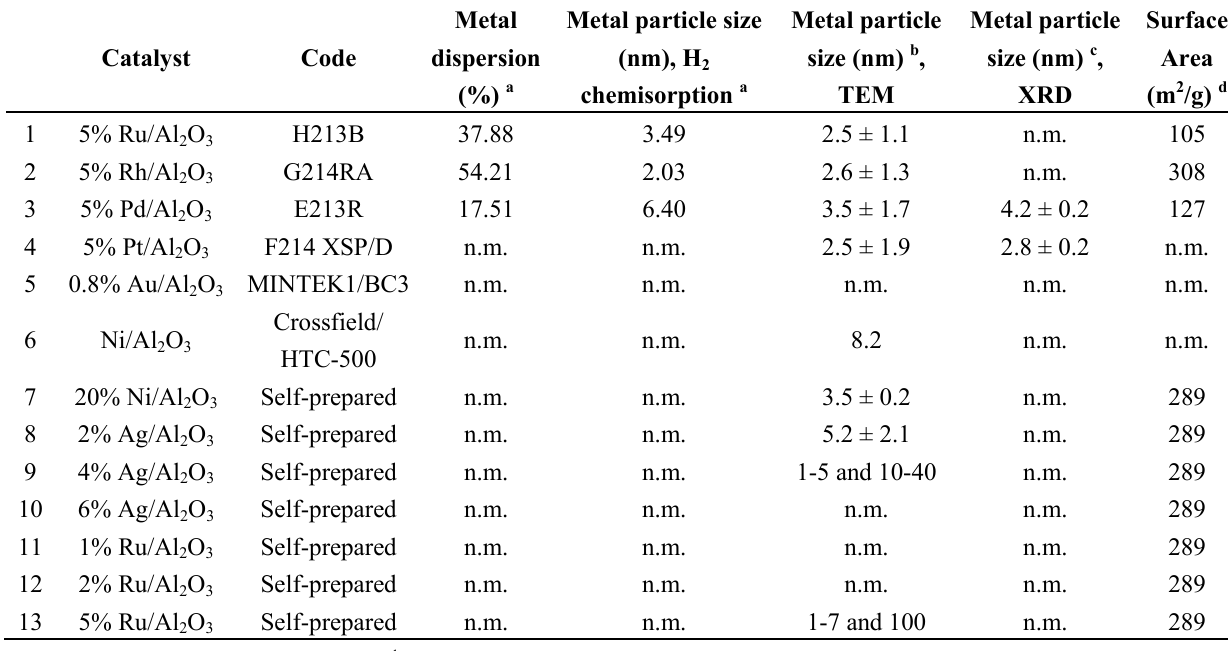
Table 2. Summary of the catalyst characterization